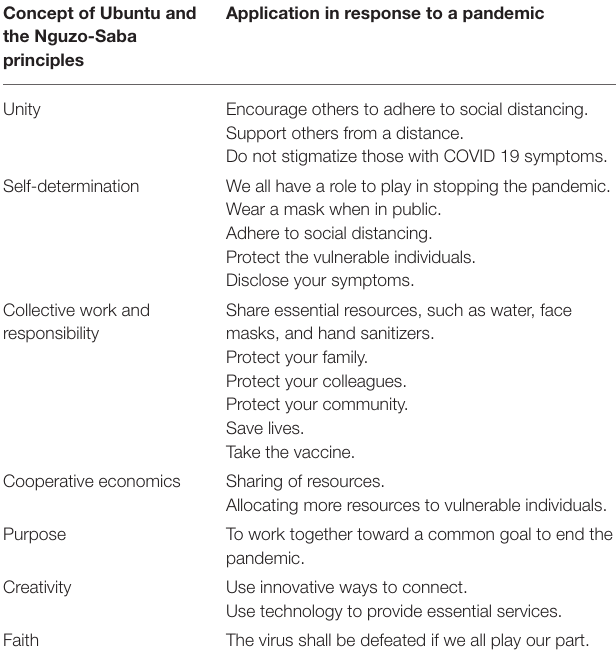
TABLE 2 | Applying the concept of Ubuntu in response to a pandemic. Concept of Ubuntu and the Nguzo-Saba